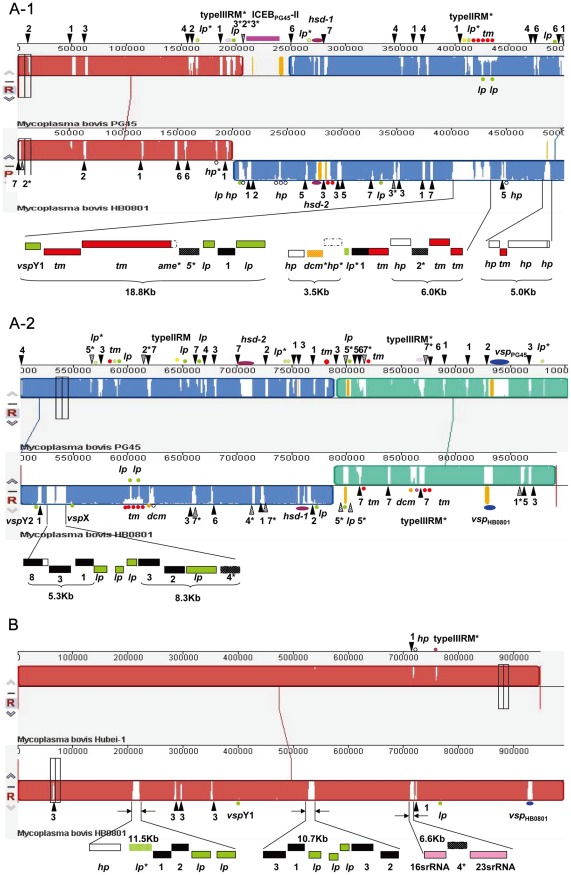
Genomic Comparison of M. bovis strains HB0801, PG45 and Hubei-1.(A) Complete genome comparison between HB0801 and PG45. A-1 and A-2 represent the upstream and downstream regions of the inversion breaking sites. (B) Genome comparison between HB0801 and Hubei-1. The middle blue region of HB0801 represents the large inverted fragment compared to PG45. The numbers 1–7 represent ISMbov1-ISMbov7, respectively (black triangles); lp: putative lipoprotein gene (green dots); tm: putative transmembrane protein gene (red dots); hsd: type I restriction modification system (purple dots); dcm: DNA-methyltransferase gene (orange dots); vsp: variable surface lipoprotein (blue dots); hp: hypothetical protein gene (hollow dots). The asterisks mark pseudo genes.